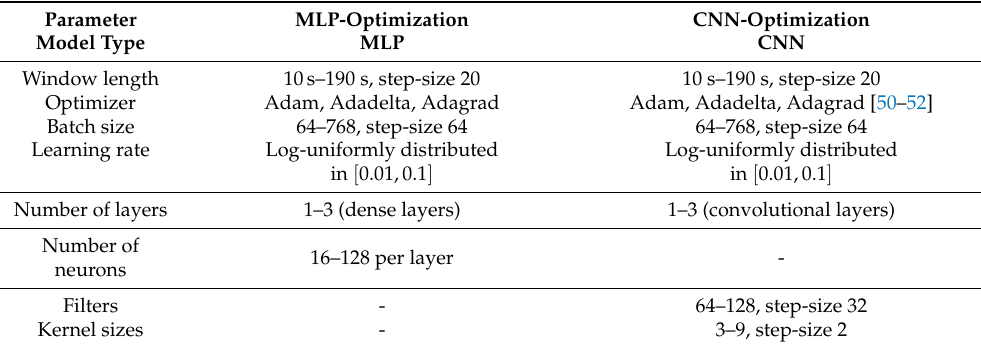
Table 3. Definition of hyper-parameter